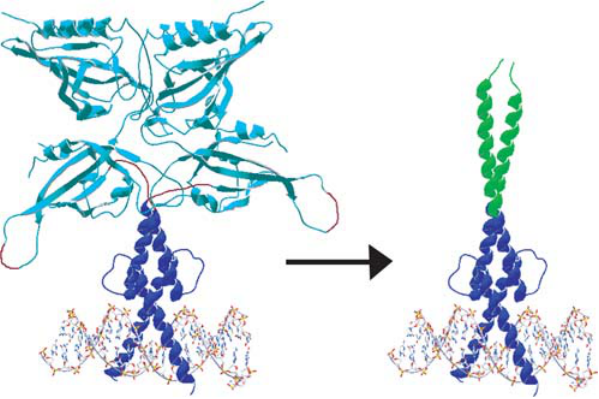
Figure 1. Schematic of minimalist design strategy. By swapping the PAS domain (330 amino acids, teal) of native bHLH/PAS protein Arnt with the much smaller C/EBP leucine zipper (29 amino acids, green helices), a hybrid of the bHLH/PAS and bZIP families was generated and expected to be bHLHZ-like in structure while retaining native Arnt DNA- binding function. Schematic adapted from PDB data. Because no high- resolution structure of an entire bHLH/PAS domain exists, we connected the bHLH domain and PAS domain from different crystal structures and estimated reasonable linkages between the two domains. A single, monomeric PAS A and PAS B repeat was isolated in the Per PAS domain structure (PDB 1WA9) [62]. The dimeric bHLHZ domain in blue (bHLH) and green (leucine zipper) is from the Myc/Max bHLHZ complex with the E-box (PDB 1NKP) [9]. The PAS and bHLH domains are to scale, and we estimated their relative positioning. The